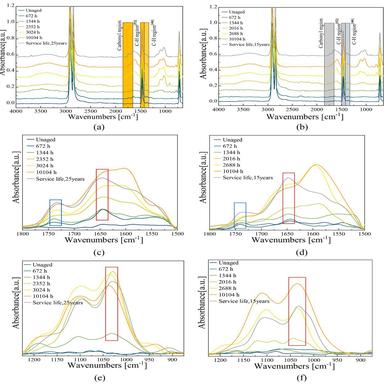
FTIR spectrums of PE80 and PE100: (a) and (b) full range, (c) and (d) magnification of the band of 1500 cm− 1 ~ 1800 cm− 1 of PE80 and PE100, respectively, (e) and (f) magnification of the band of 850 cm− 1 ~ 1225 cm− 1 of PE80 and PE100, respectively.